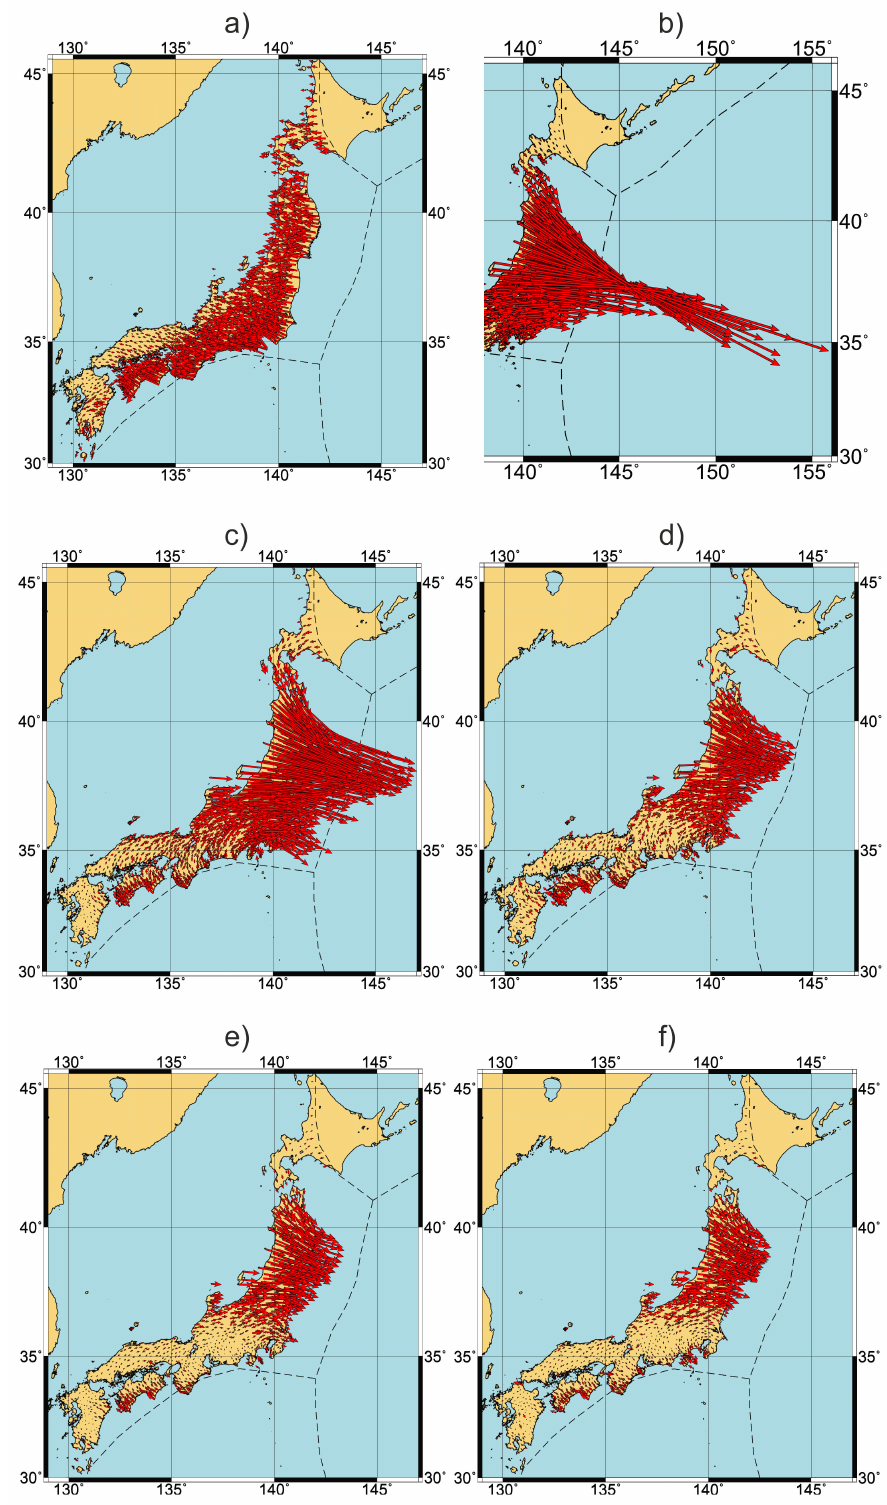
Figure 6. Surface motions in Japan before ( a ), during ( b ) and after ( c – f ) 2011 Tohoku earthquake estimated from GEONET GNSS data, modified from [18]. Red arrows show velocity distributions for time intervals as following: 11 March 2010–10 March 2011 ( a ); 11 March 2011 ( b ); 12 March 2011–10 March 2012 ( c ); 11 March 2012–10 March 2013 ( d ); 11 March 2013–10 March 2014 ( e ), and 11 March 2014–10 March 2015 ( f ). Velocities are relative to the South American lithospheric